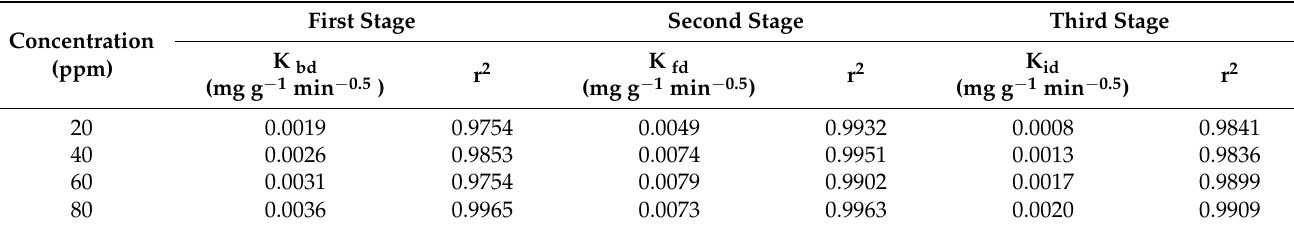
Table 6. Intraparticle diffusion modeling parameters of